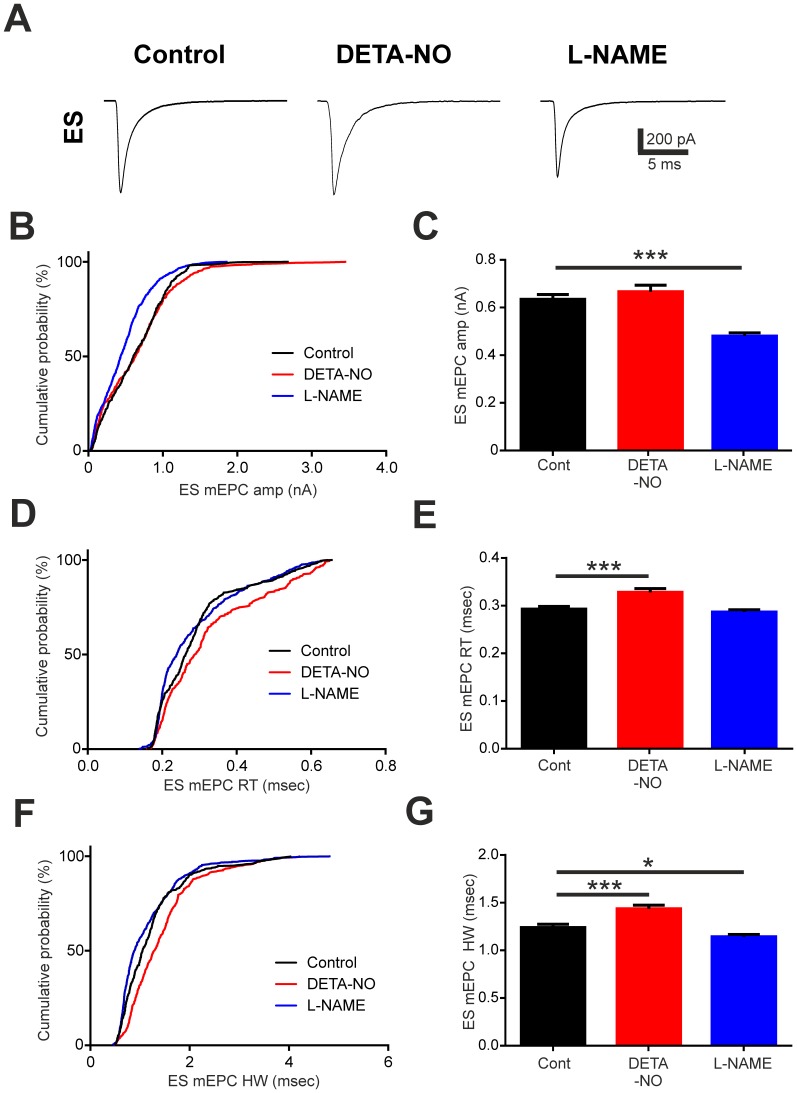
Developmental manipulation of NO affects ES mEPC kinetics.Average traces of miniature end plate currents (mEPCs) captured during voltage recordings in embryonic slow (ES) fibres of control (left), DETA-NO raised (middle) and L-NAME raised (right) fish. B-G. Cumulative percentage plots and bar charts of ES mEPC amplitude (amp, B,C), rise time (RT, D,E) and half-width (HW, F,G) for each experimental condition. Data in C,E,G are represented as mean ± SEM. * p<0.05, *** p<0.001.